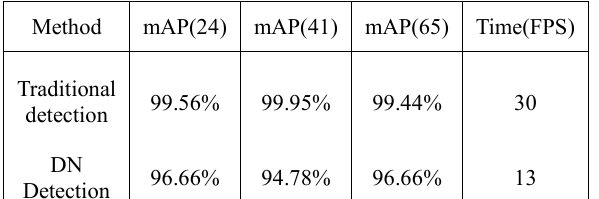
Table 3. The accuracy of detection model and classification